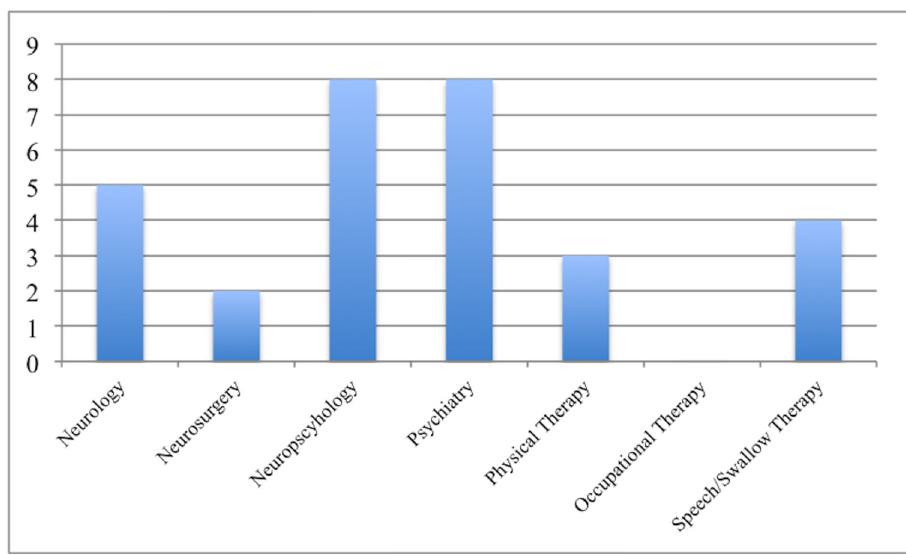
Fig 3. Number of concerns reported per evaluating service on those patients with UH during the interdisciplinary